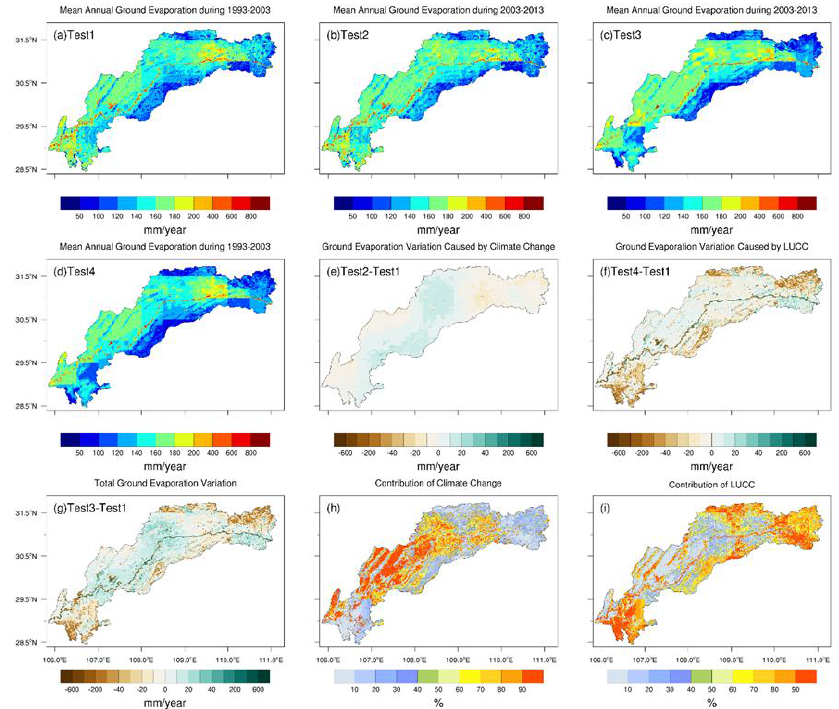
Figure 14. The spatial differences and the contribution of climate change and LUCC to ground evaporation before and after impoundment.